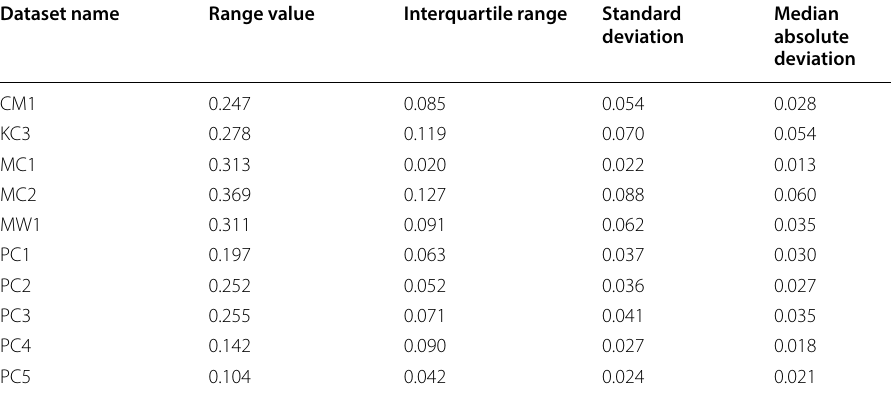
Table 3 Eigenvector dispersion